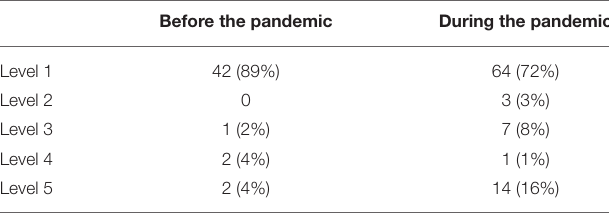
TABLE 2 | Comparison of seizure control outcomes in the H–GP group before and during the first peak of the pandemic. Before the pandemic During the pandemic